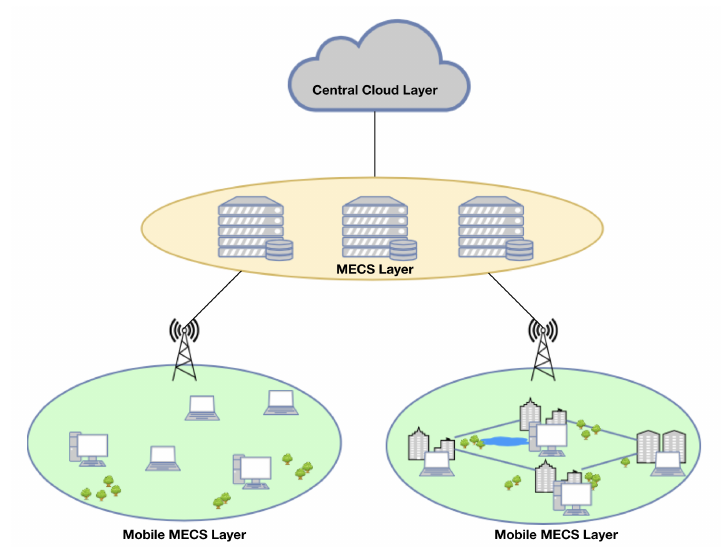
Figure 1. The design of the proposed mobile personal Multi-Access Edge Computing (MEC) architecture.